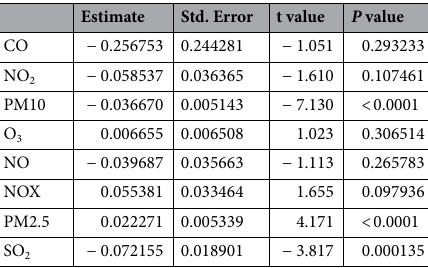
Table 4. Coefficients of the Binomial GLM model fitted to the rainy season rainfall occurrence data (2000–